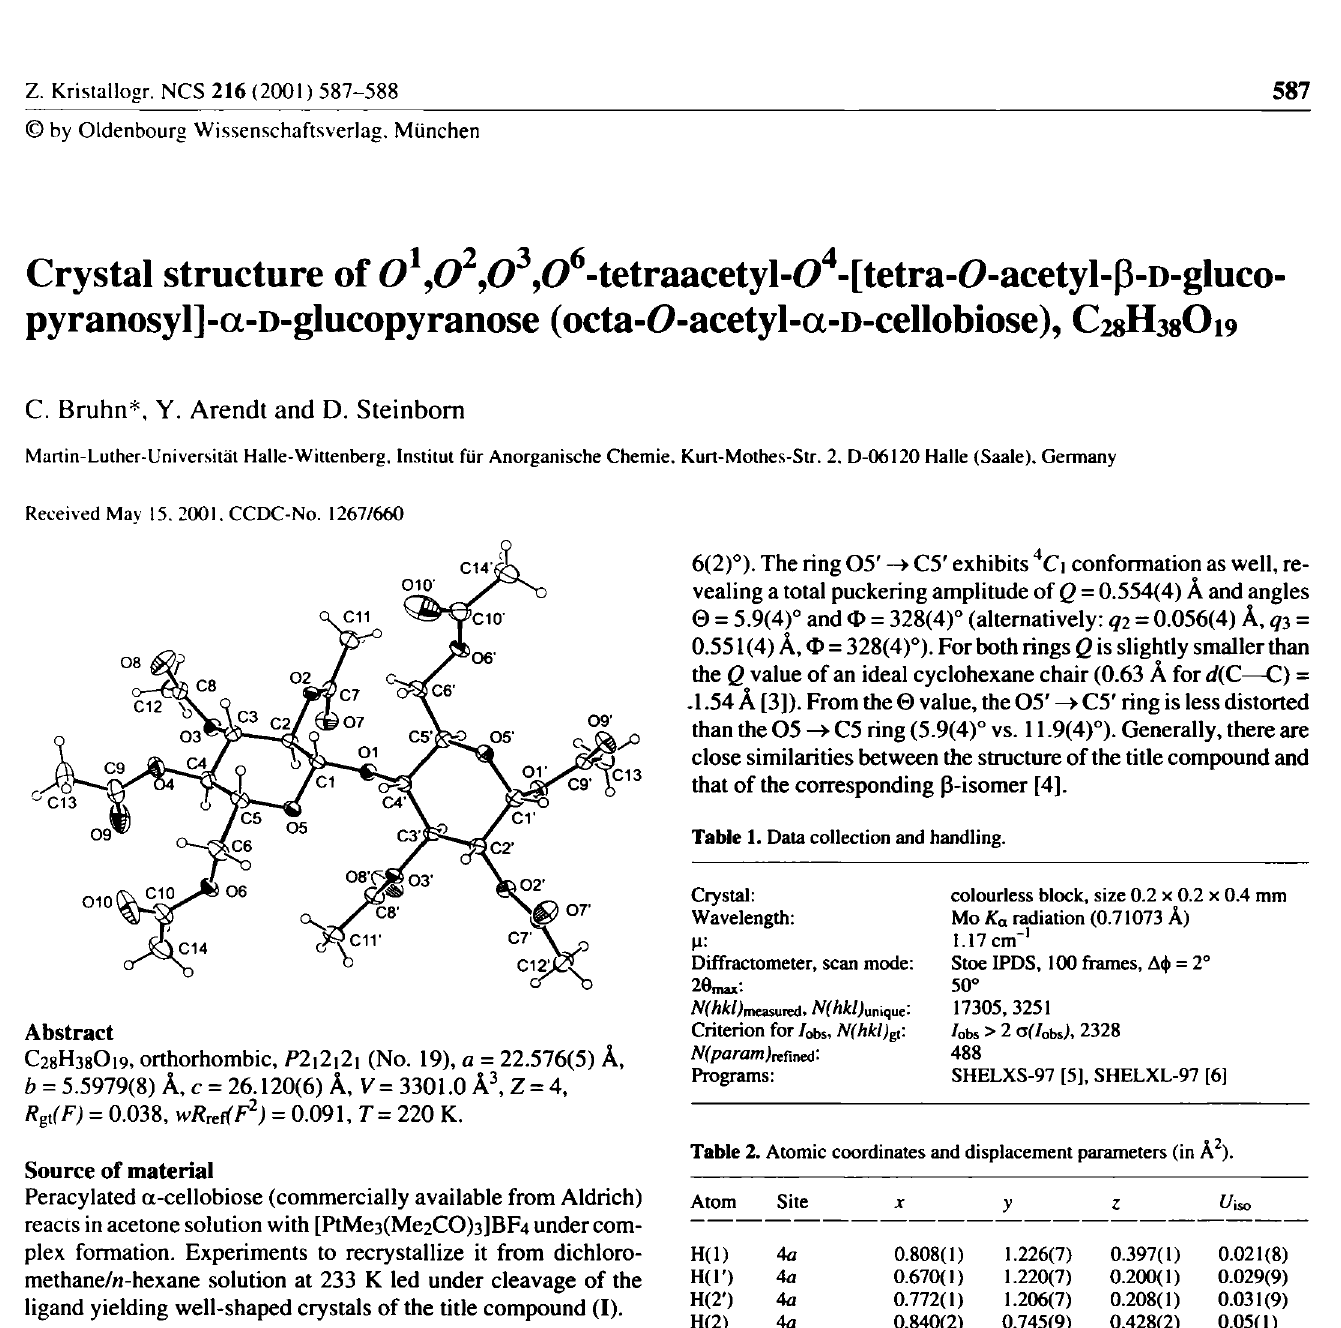
Table 2. Atomic coordinates and displacement parameters (in A 2